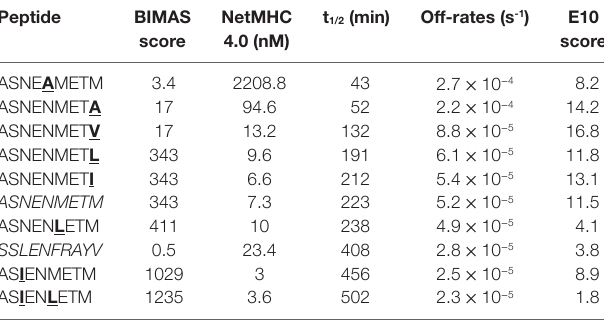
Table 1 | Peptide sequences and off-rates.